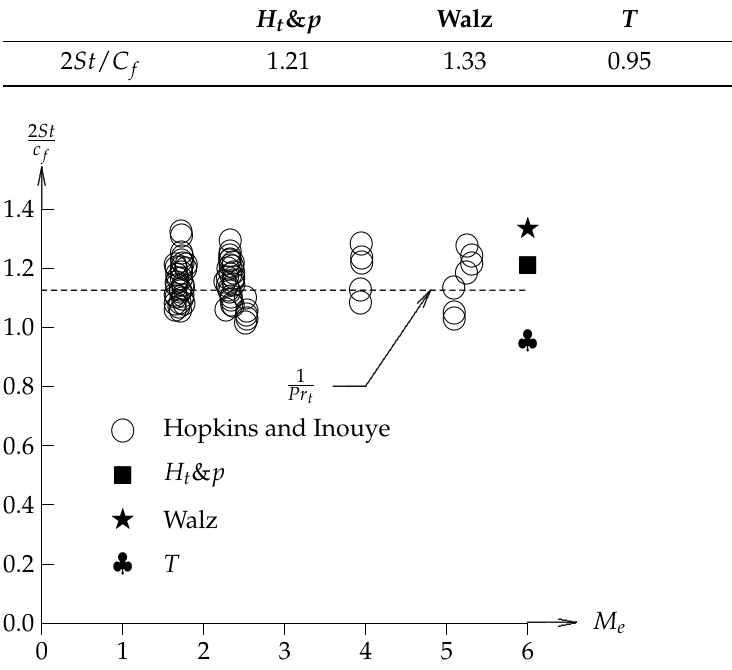
Figure 3. Scatter in Reynolds Analogy Factor (Hopkins and Inouye